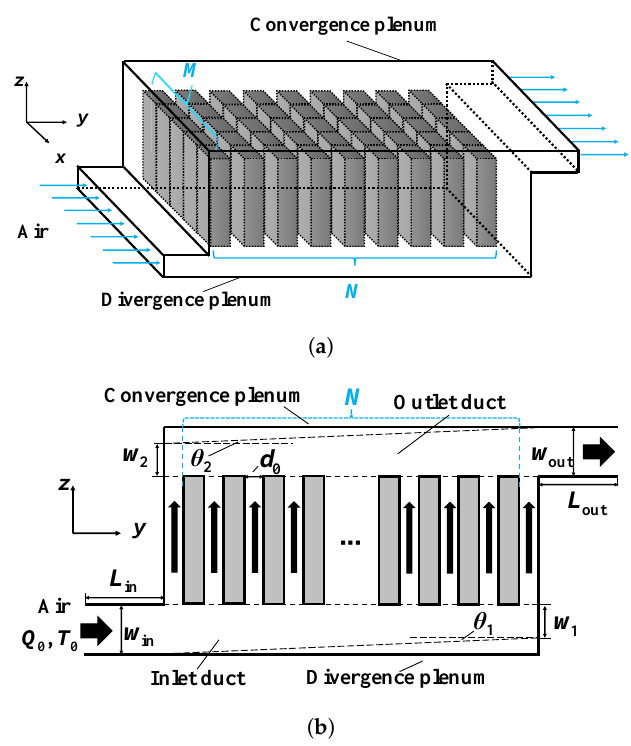
Figure 2. Schematic of the parallel air-cooled battery thermal management system (BTMS). ( a ) Orthographic view of the BTMS; ( b ) Side view of the